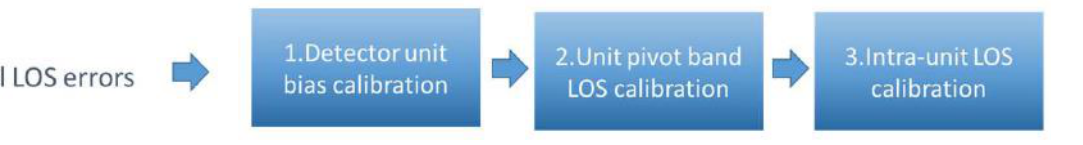
Figure 15. New LOS calibration in three steps.